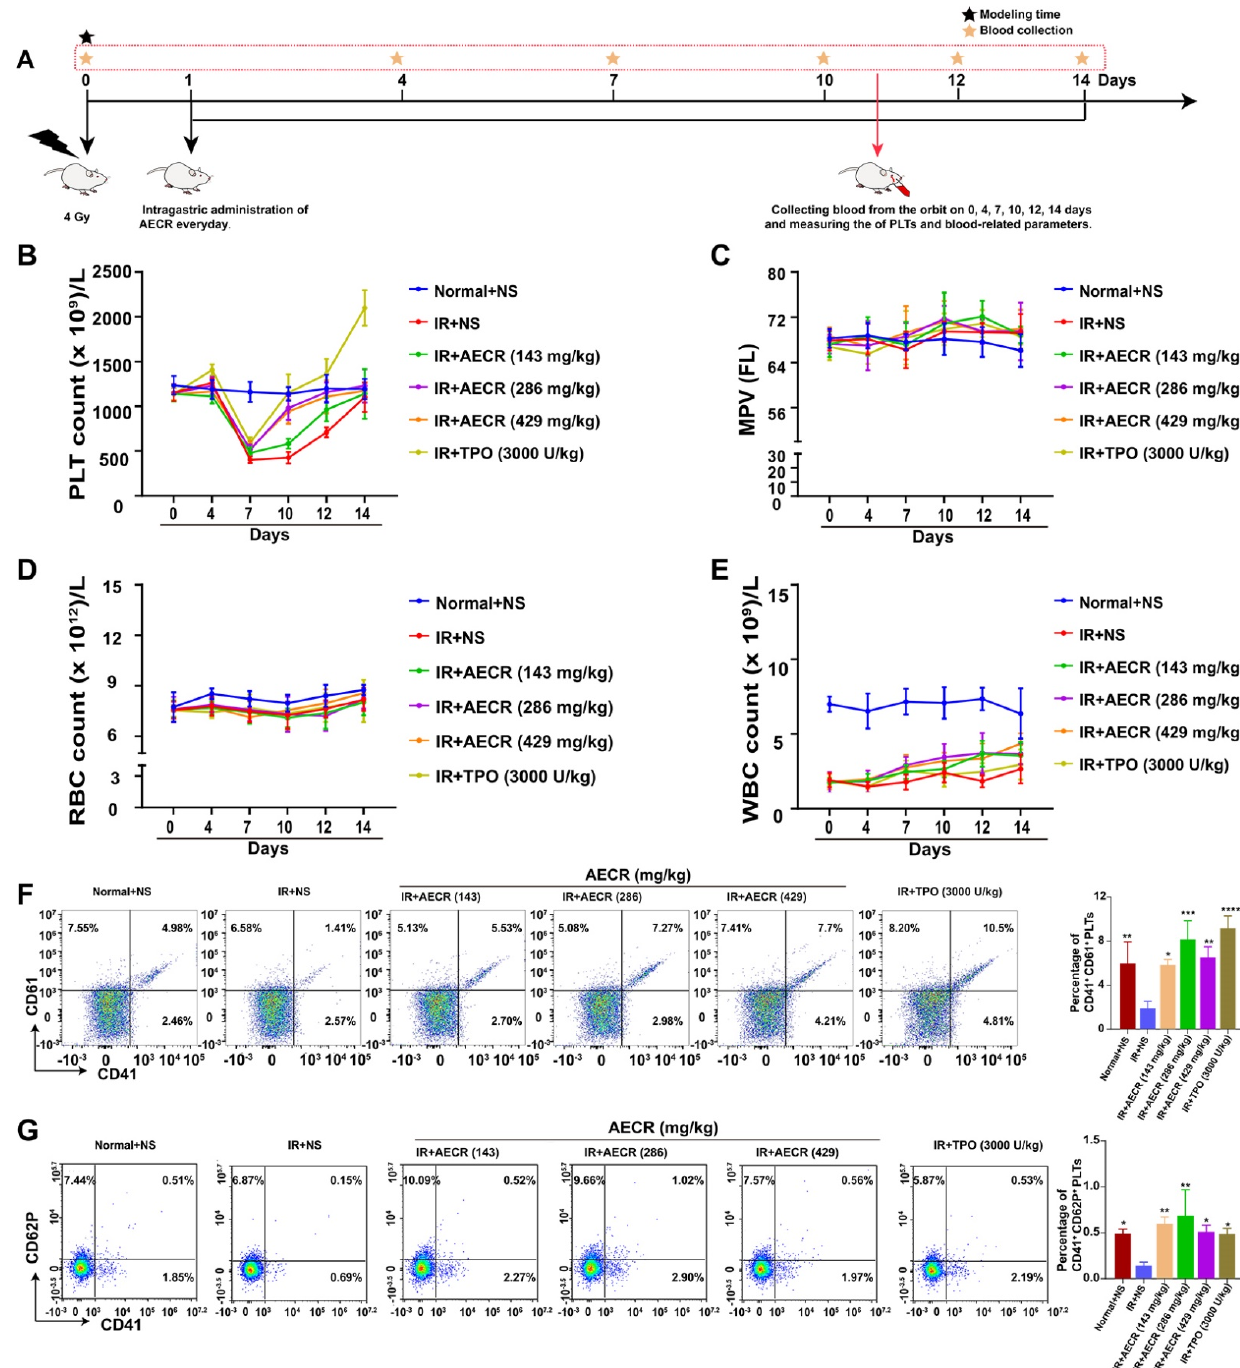
Figure 4. AECRs accelerate the recovery of peripheral blood PLTs in mice with thrombocytopenia. ( A ) Schematic diagram of animal experiment. ( B – E ) AECRs affect the PLTs, MPV, RBCs, and WBCs in peripheral blood. The values represent the means ± standard deviations (n = 8). * p < 0.05, ** p < 0.01, *** p < 0.001 versus the model group. ( F , G ) The CD41 + CD61 + and CD41 + CD62P + content on platelets were analyzed by flow cytometry on day 10 after treatment with AECRs. On the right, these statistical histograms show the proportion of CD41 + CD61 + and CD41 + CD62P + PLTs in each group. The values represent the means ± standard deviations (n = 3). * p < 0.05, ** p < 0.01, *** p < 0.001, **** p < 0.0001 versus model group. AECRs: aqueous extracts of Cibotii Rhizoma; PLTs: platelets; MPV: mean platelet volume; WBCs: white blood cells; RBCs: red blood cells.